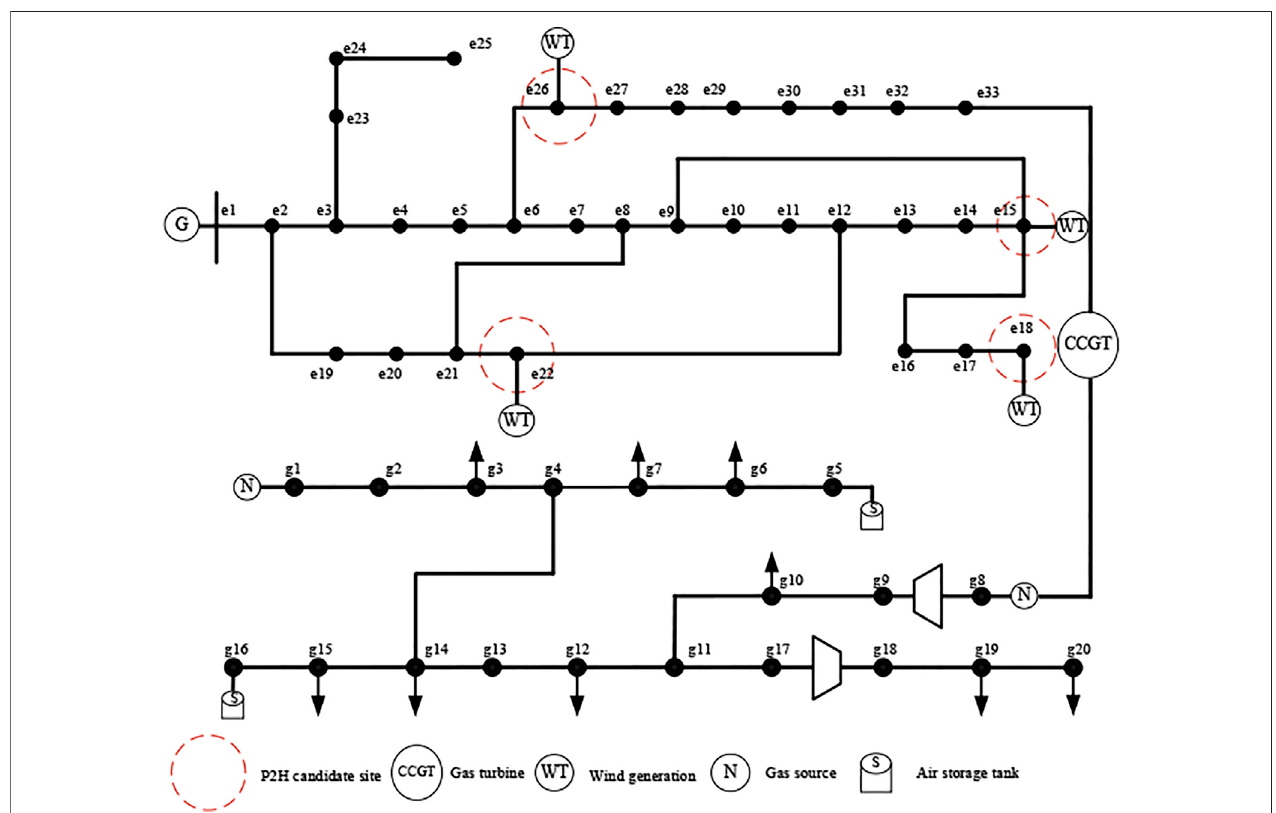
FIGURE 6 | Con fi guration of the hybrid renewable energy